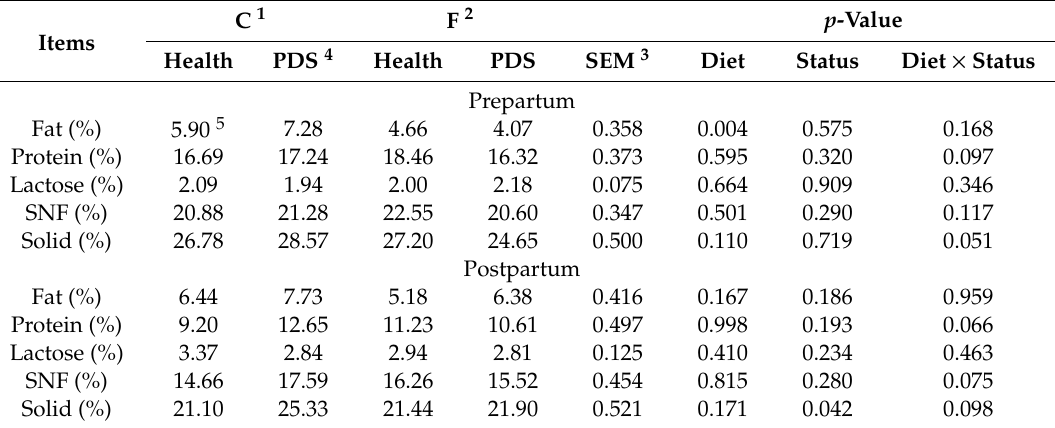
Table 4. E ff ect of Bacillus licheniformis -fermented products and postpartum dysgalactia syndrome on the milk composition of